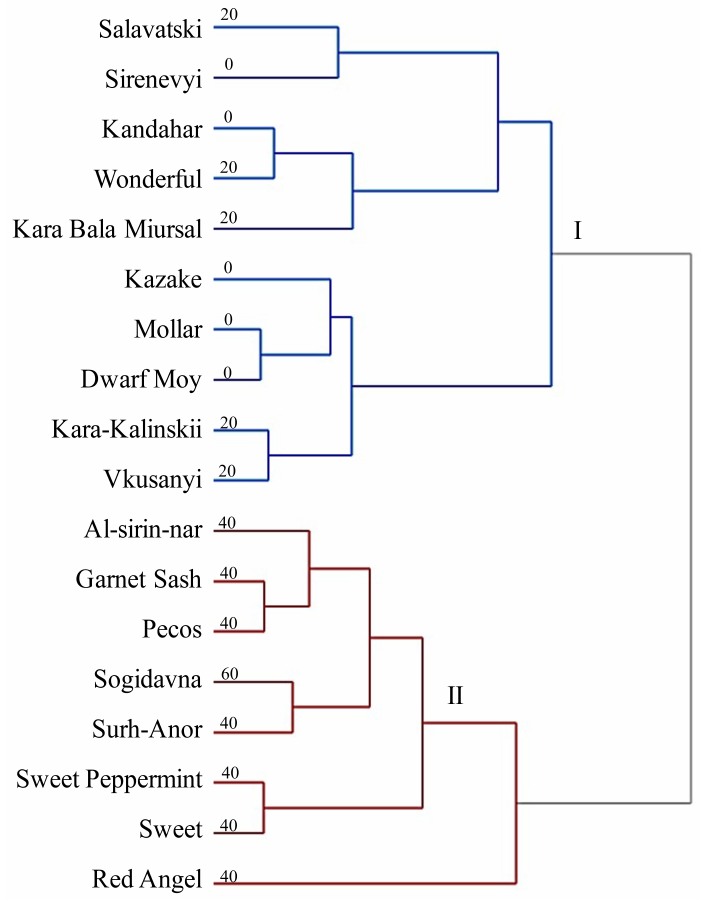
Figure 2. The dendrogram of cluster analysis of 18 pomegranate cultivars used the method of Ward linkage and squared Euclidian distance. It was based on di ff erence values of plants between salt-treated group and control of 12 multivariate parameters, including total dry weight, root / shoot ratio, root length, root number, shoot length, new shoot number, leaf area, salt damage rate, relative water content, SPAD, Pn, and g s . The numbers are foliar salt damage rate